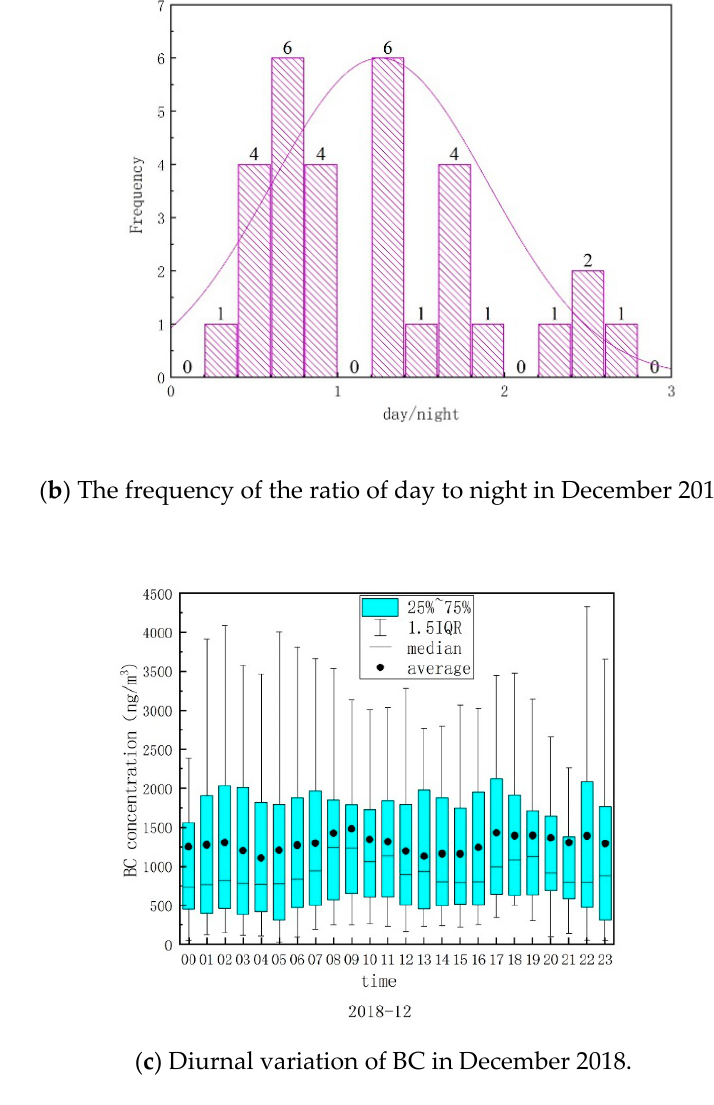
Figure 8. Day/night variation in BC in December 2018.